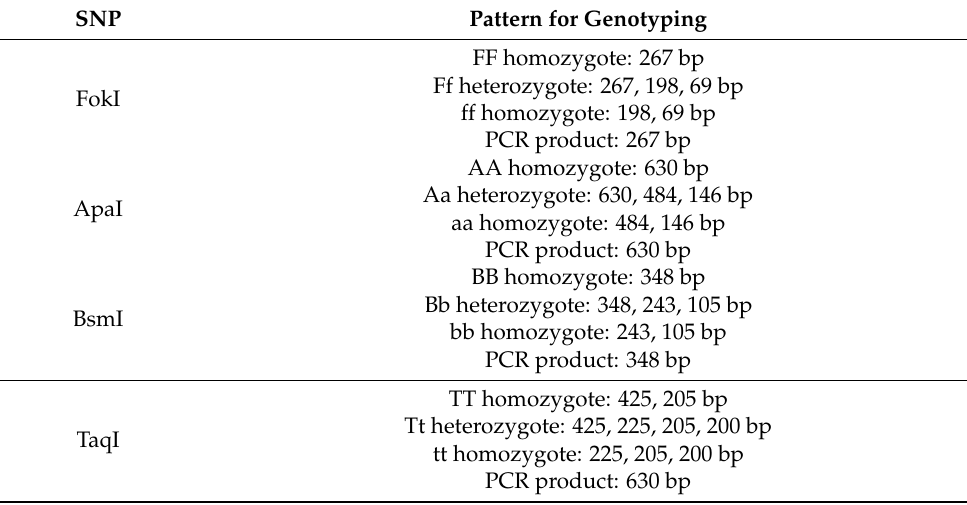
Table 3. Pattern for